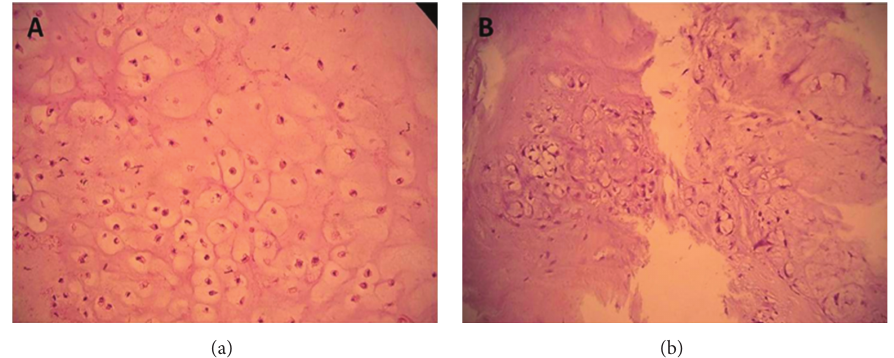
F 4: Photomicrograph of the resected tumor showing (Hematoxylin and Eosin, pleomorphism;